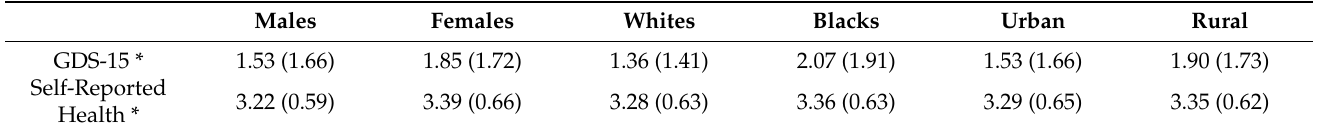
Table 2. Depression and Self-Rated Health by Sex, Race, and Geographical